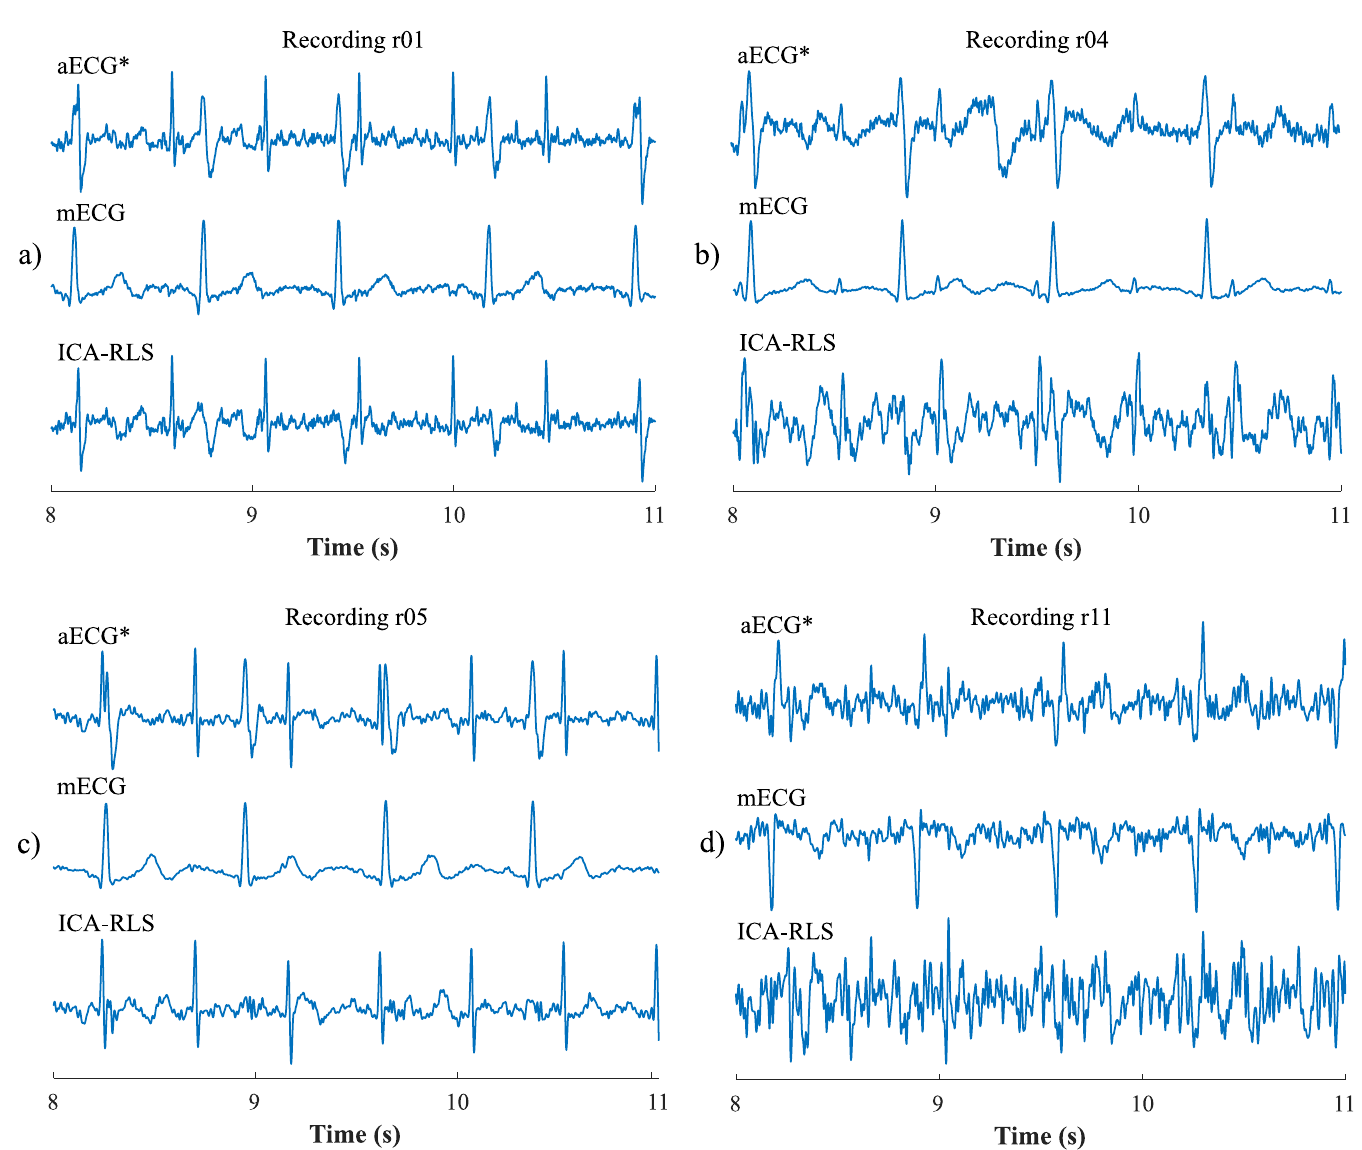
Fig 16. The influence of the mECG and aECG � components determined with the help of the ICA on the resulting quality of the fECG signal extracted using the ICA-RLS method. The recordings: a) r01 and c) r05 are examples of well extracted mECG and aECG � components. The recording b) r04 and d) r11 represent a less accurate extraction of the fECG. This is a result of the low magnitude of the fetal component and the presence of noise and residues of the fetal component in the mECG